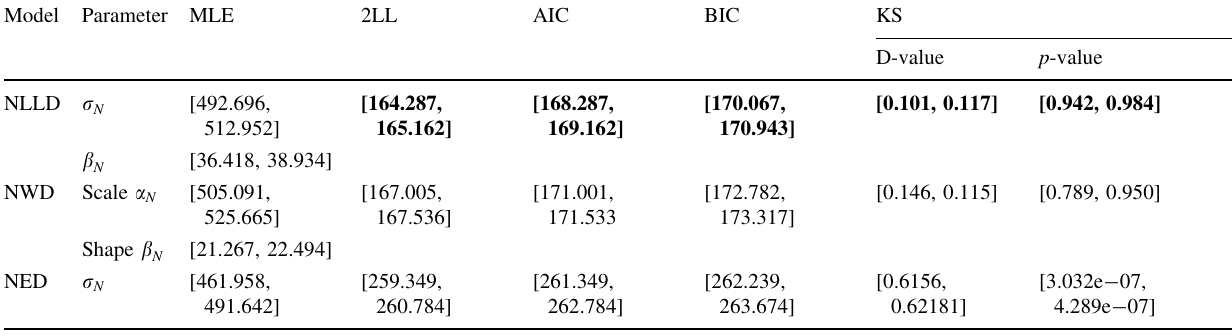
Table 5 The neutrosophic parametric estimation and goodness of fit for alloy melting points data Model Parameter